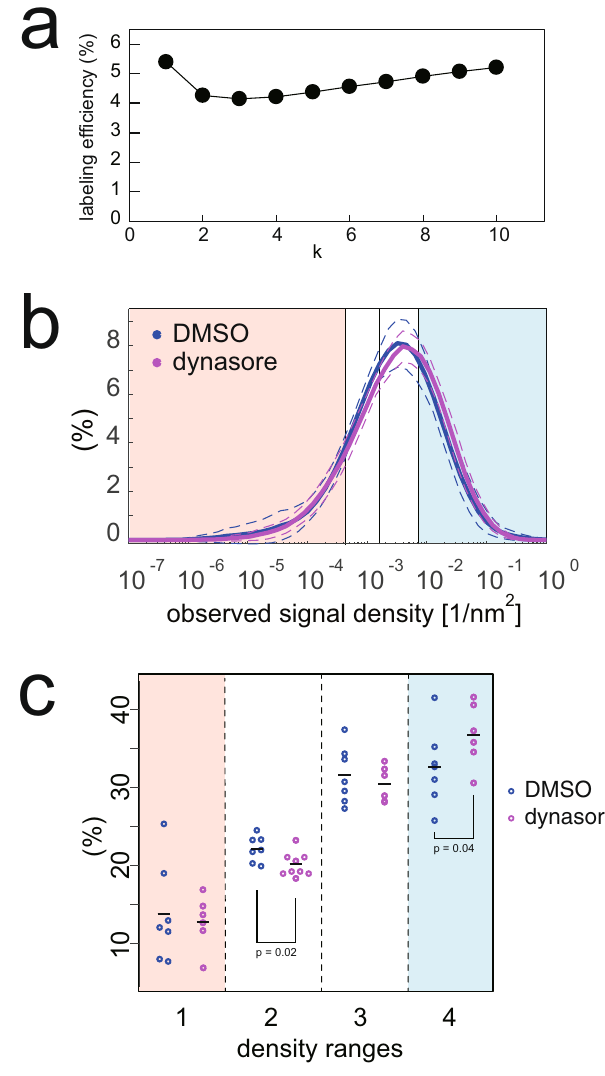
Figure 6. Local density estimation from STORM signals of clathrin heavy chain. ( a ) Observation efficiency estimations of clathrin heavy chain with the k th NND plotted against k. ( b ) The average density distributions of the STORM signals by the 8 th NND of clathrin heavy chain in cells under isotonic culture medium (blue), and 80 μ M dynasore treatment for 10 min (magenta), as analysed in Fig. 3. The dashed line indicates the standard deviation. ( c ) Percentages of clathrin heavy chain by the density ranges in each cell allocated as in Fig. 3f. The average percentages at the flattened range (second range) and the high-density range (fourth range) between cells treated with DMSO and dynasore were significantly different. Indicated p-values were obtained using the Student’s